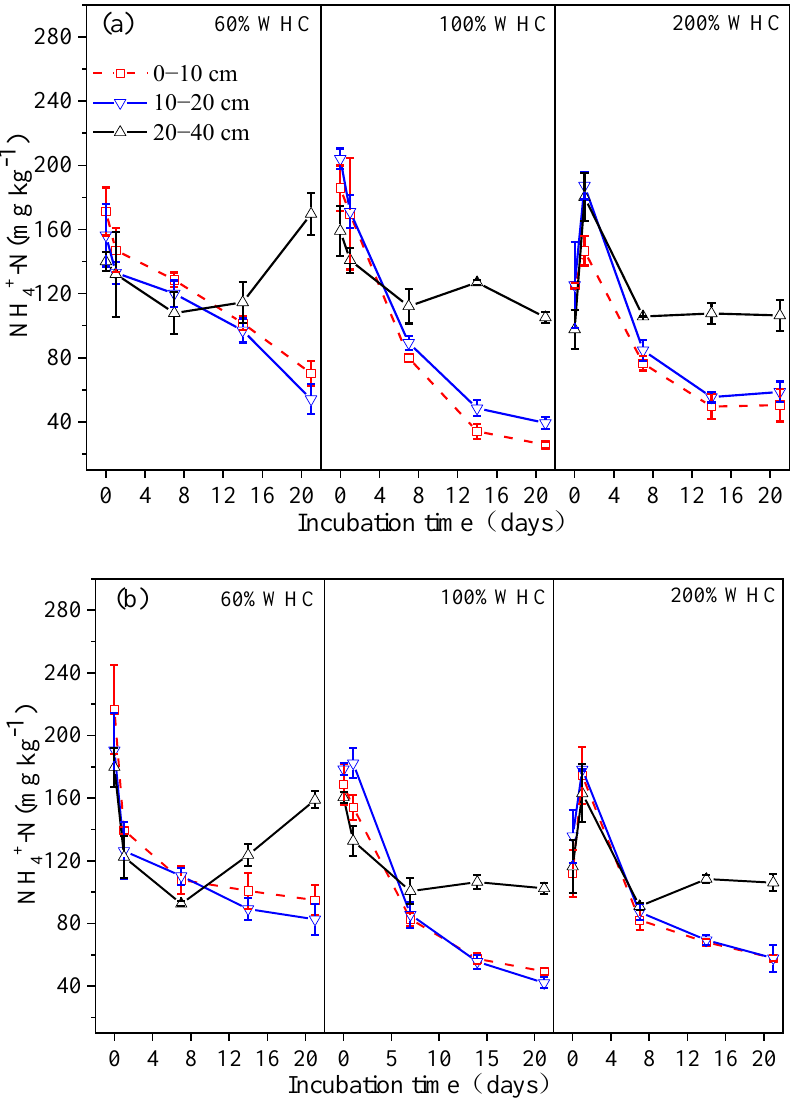
Figure 4. The dynamic changes of NH 4+ -N contents in hydromorphic ( a ) and gleyed ( b ) paddy soils at three soil moisture levels during 21-day incubation. The values represent the mean of three replicates, and the error bars represent standard errors.